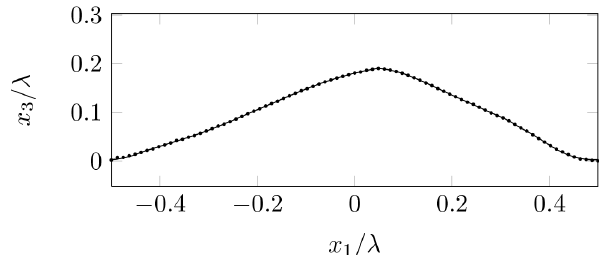
Figure 2. Comparison of the ripple shape measured in the Mr5b63 experiments of van der Werf et al. (2007) ( • ) to that used in LES model (–), based on fitting Eq. (18) to the ripple profiles (with coef- ficients in Table 1).